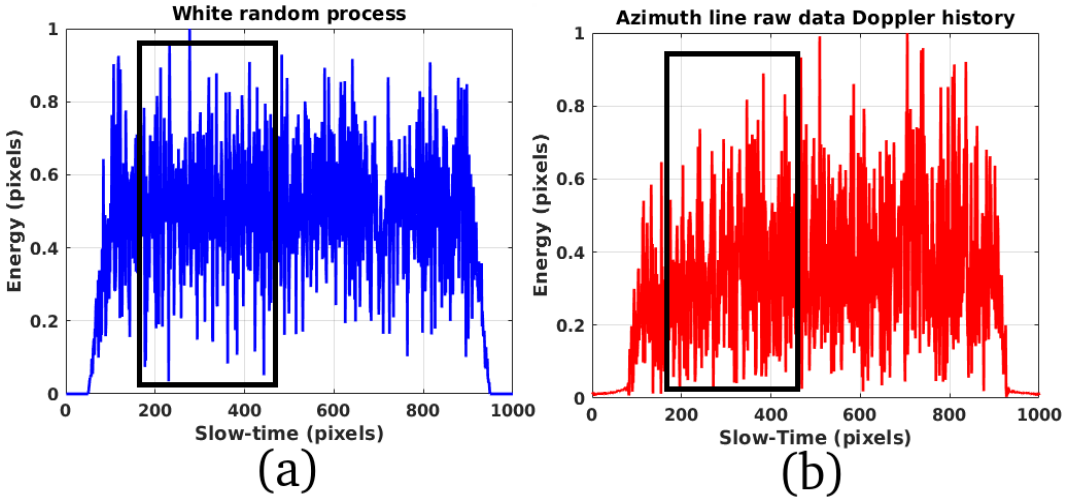
Figure 2. ( a ): White random process. ( b ): CSK raw data of a Doppler line.